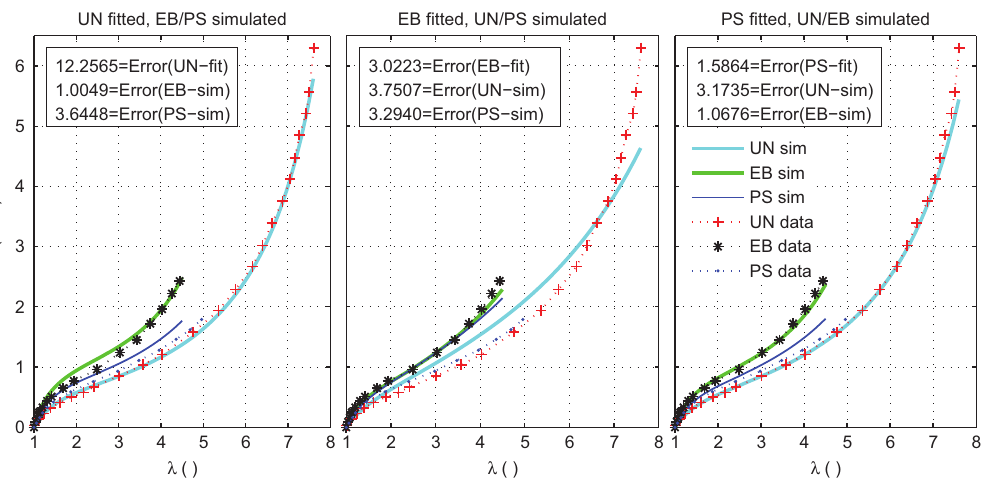
Figure 16 Performance of the extended tube model on the Treloar data. The fitting quality is excellent in all three deformation modes except for a bit overestimation in uniaxial simulation by the EB-fitted para meters (middle). This model (with low number of parameters, four in total) fits the best among all models so far studied in previous